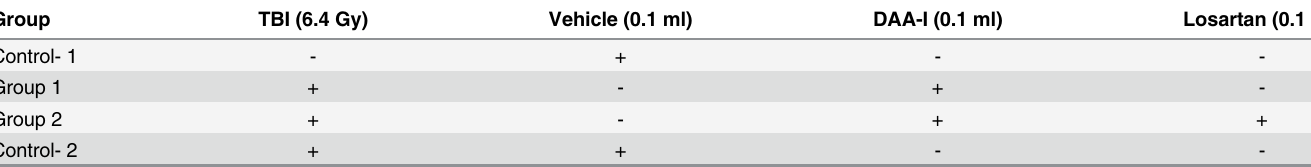
Table 1. Drug administration protocol of non-irradiated and irradiated